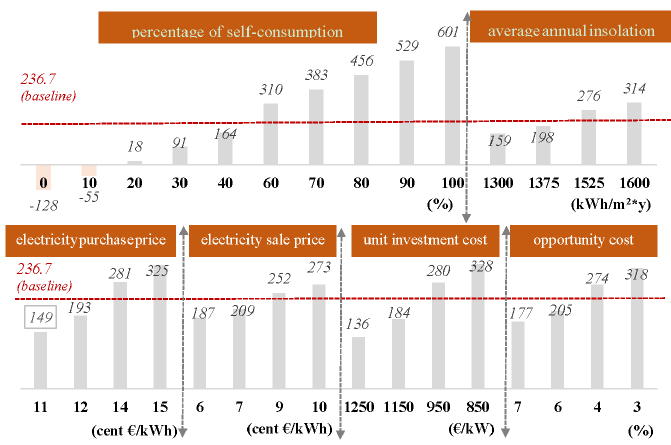
Figure 3. Sensitivity analysis–NPV (k€) for a 400 kW power system. Energies 2015 , 8 , page–page